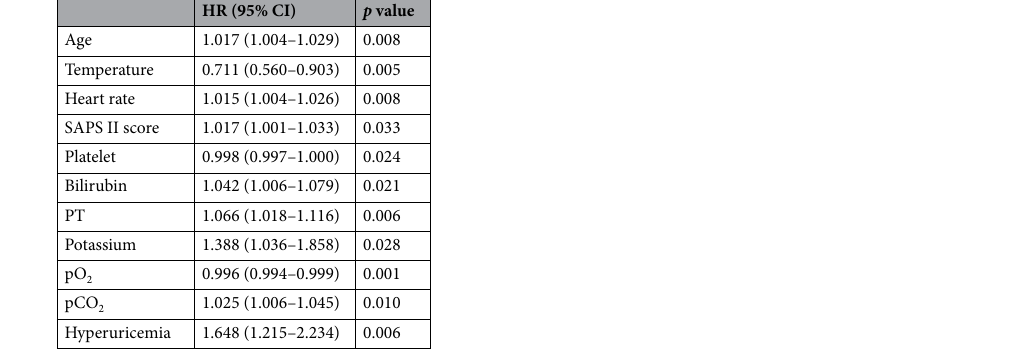
Table 3. Cox regression analyses to assess risk factors associated with 90-day all-cause mortality in patients with sepsis. PT prothrombin time, pO2 partial pressure of oxygen, pCO2 partial pressure of carbon dioxide.